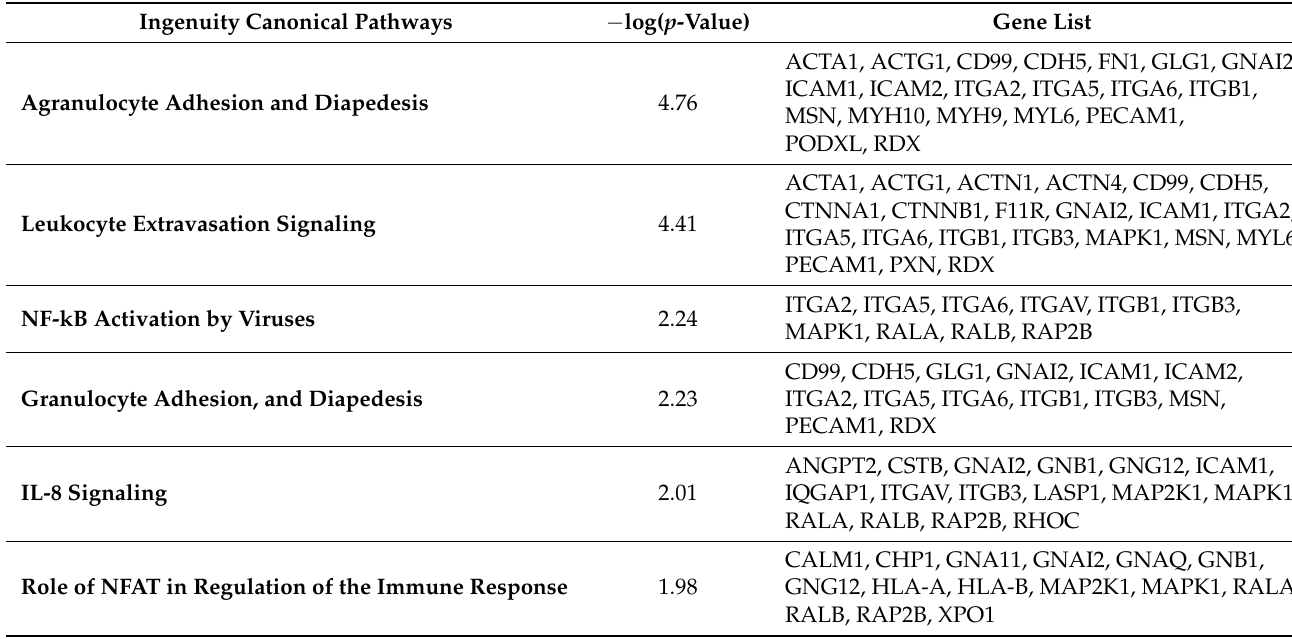
Table 3. Inflammatory pathways and list of proteins modulated in eEV-IL-3 with respect to eEV. Bold pathways are statistically